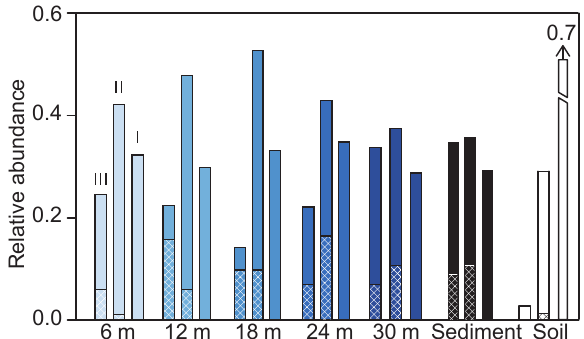
Figure 5. Spatial variation in the water column of the relative abun- dance of group I, II, and III brGDGTs in SPM as a function of water depth. For each group, the relative abundance at depths of 6 (lightest blue), 12, 18, 24, and 30m (darkest blue) is plotted next to the av- erage surface sediment (black) and catchment soil (white). For each category, brGDGT groups III, II, and I are shown in that order (left to right). Lines in each bar represent the relative abundance of 5- and 6-methyl brGDGTs, with cross hatching representing 6-methyl